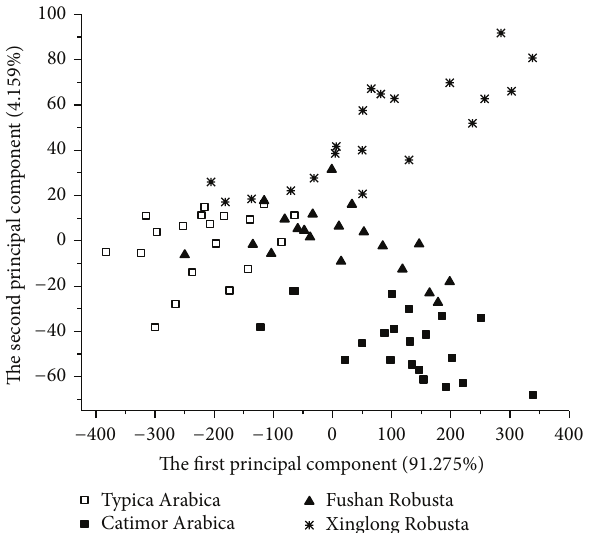
Figure 2: Scores scatter plot of the first principal component and the second principal component.